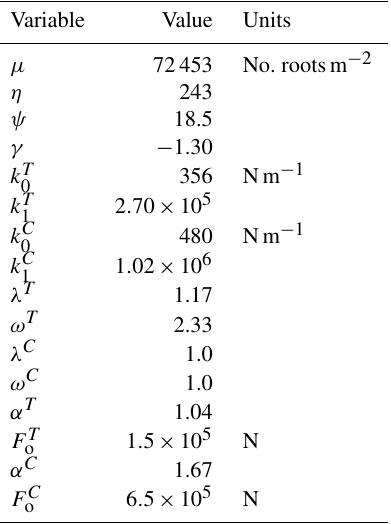
Table 3. Root parameters used in